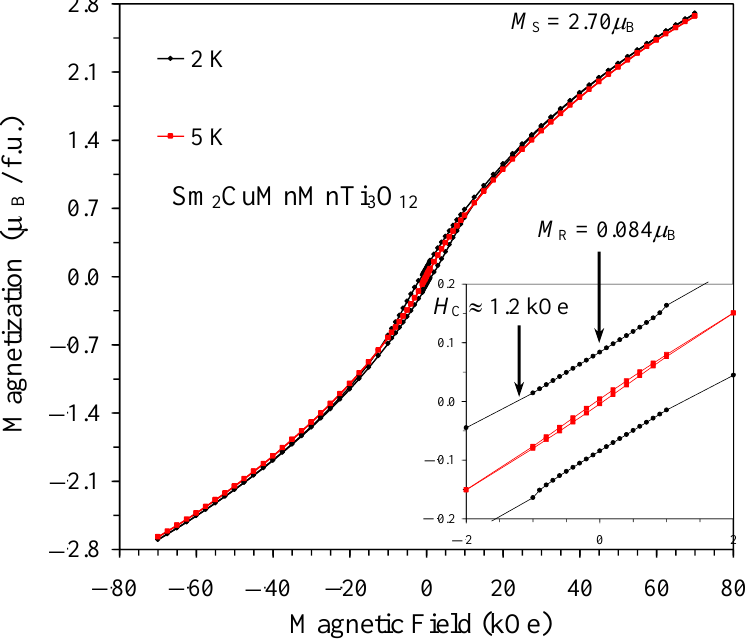
Figure 5. M versus H curves of Sm 2 CuMn(MnTi 3 )O 12 at T = 2 K (black) and T = 5 K (red) (f.u.: formula unit). The inset shows details near the origin. Parameters of the M versus H curve at T = 2 K are given: M S is the magnetization value at H = 70 kOe, M R is the remnant magnetization, and H C is the coercive field.